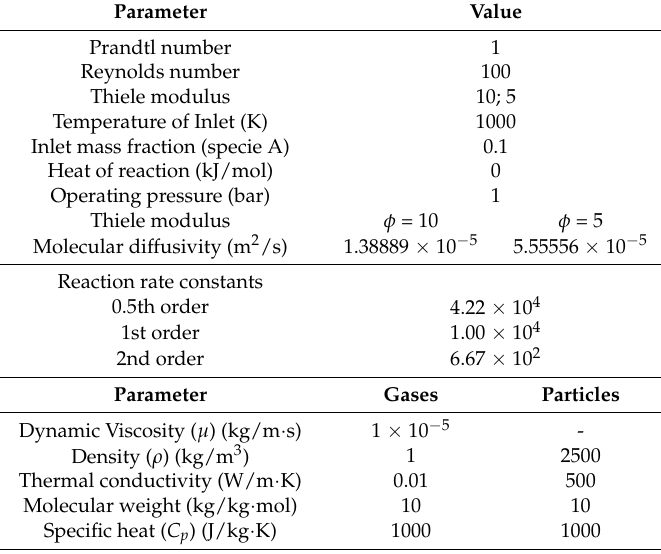
Table 2. Flow properties for CFD simulation. The flow properties are based on the range of dimensionless parameters (Re, Pr) in the PR-DNS